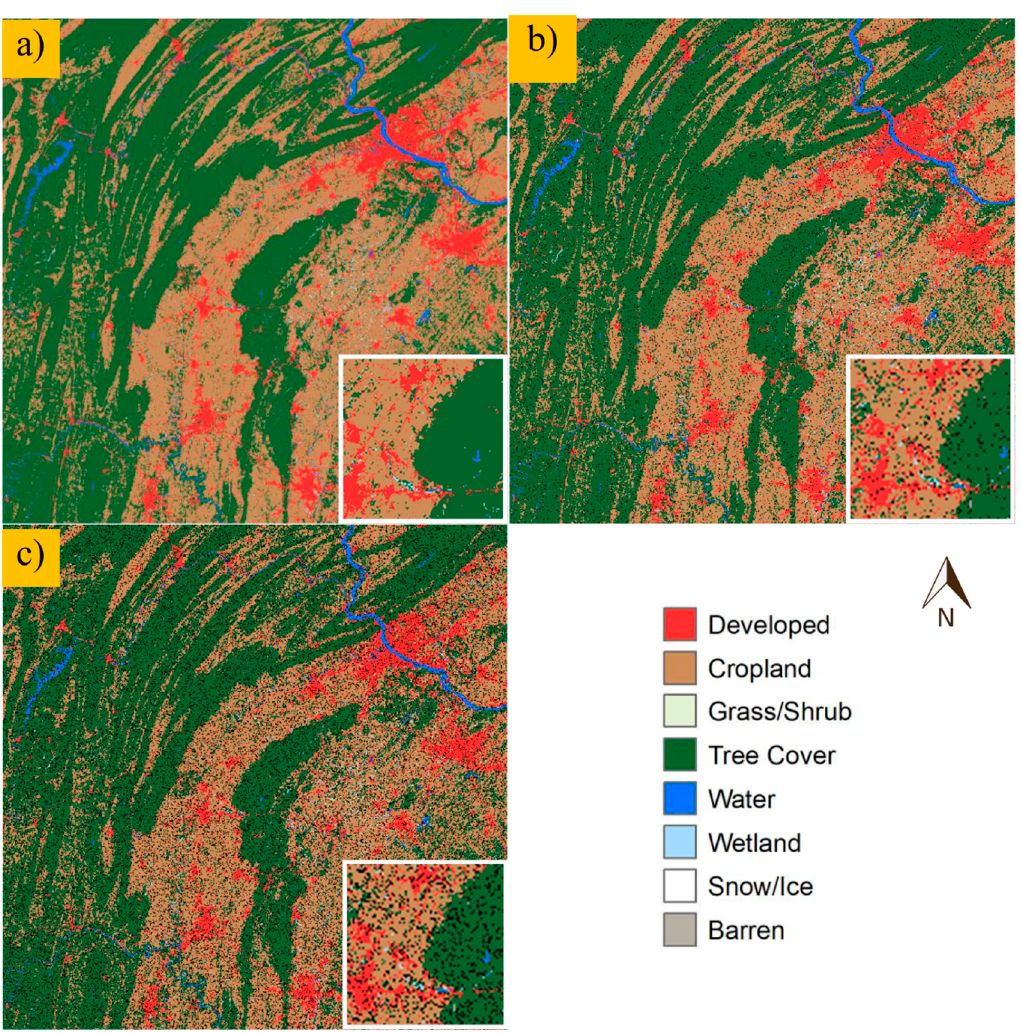
Figure 1. Illustration of land cover types in one tile (150 km by 150 km) at panel ( a ), and synthetic data with 5% failed pixels (black color) at panel ( b ) or 15% failed pixels at panel ( c ). The lower-left corner of each panel displays the zoom-in view of the image center.